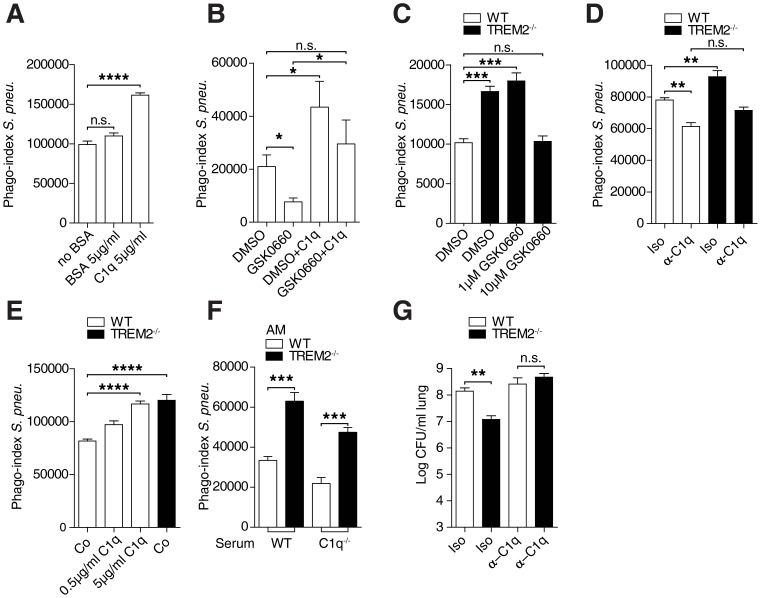
Enhanced phagocytosis by Trem-2
−/− AM depends on C1q.(A) WT AM were adhered to C1q, control BSA or uncoated plates for 3 h prior to incubation with FITC labeled S. pneumoniae (MOI 100) and phagocytosis was assessed using FACS 1 h later (n = 3–4 per condition). (B) WT AM (n = 6–7 per condition) were pre-treated for 24 h with 10 µM PPAR-δ inhibitor GSK0660 or DMSO control after which, the cells were adhered to C1q or control plates for 3 h and phagocytosis of FITC labeled S. pneumoniae (MOI 100) was assessed 1 h later using FACS. (C) WT and Trem-2
−/− AM (n = 4 per genotype/condition) were pre-treated for 24 h with the indicated doses of the PPAR-δ inhibitor GSK0660 or DMSO control after which phagocytosis of FITC labeled S. pneumoniae (MOI 100) was assessed 1 h later using FACS. (D) WT and Trem-2
−/− AM were pre-treated for 1 h with 10 µg/ml C1q blocking antibody or isotype control and phagocytosis of FITC labeled S. pneumoniae (MOI 100) was assessed 1 h later using FACS (n = 4 per genotype/condition). (E) WT and Trem-2
−/− AM (n = 4–7 per condition) were adhered for 3 h to plates coated with the indicated conditions prior to incubation with FITC labeled S. pneumoniae (MOI 100) and phagocytosis was assessed using FACS. (F) WT and Trem-2
−/− AM (n = 4 per genotype) were incubated with FITC labeled S. pneumoniae (MOI 100) that were pre-opsonised with 10% WT or C1qa−/− serum for 30 min after which phagocytosis was assessed 1 h later using FACS (G) WT and Trem-2
−/− mice (n = 17 per condition) were intranasally treated with 125 µg C1q blocking antibody or isotype control prior to infection with 6×104 CFU S. pneumoniae. 48 h post infection lung bacterial CFUs were enumerated. Data represent mean ± SEM; ** p<0.005, *** p<0.001, **** p<0.0001. Data in (A, C–F) are representative of two independent experiments, (B and G) are pooled data from two independent experiments.